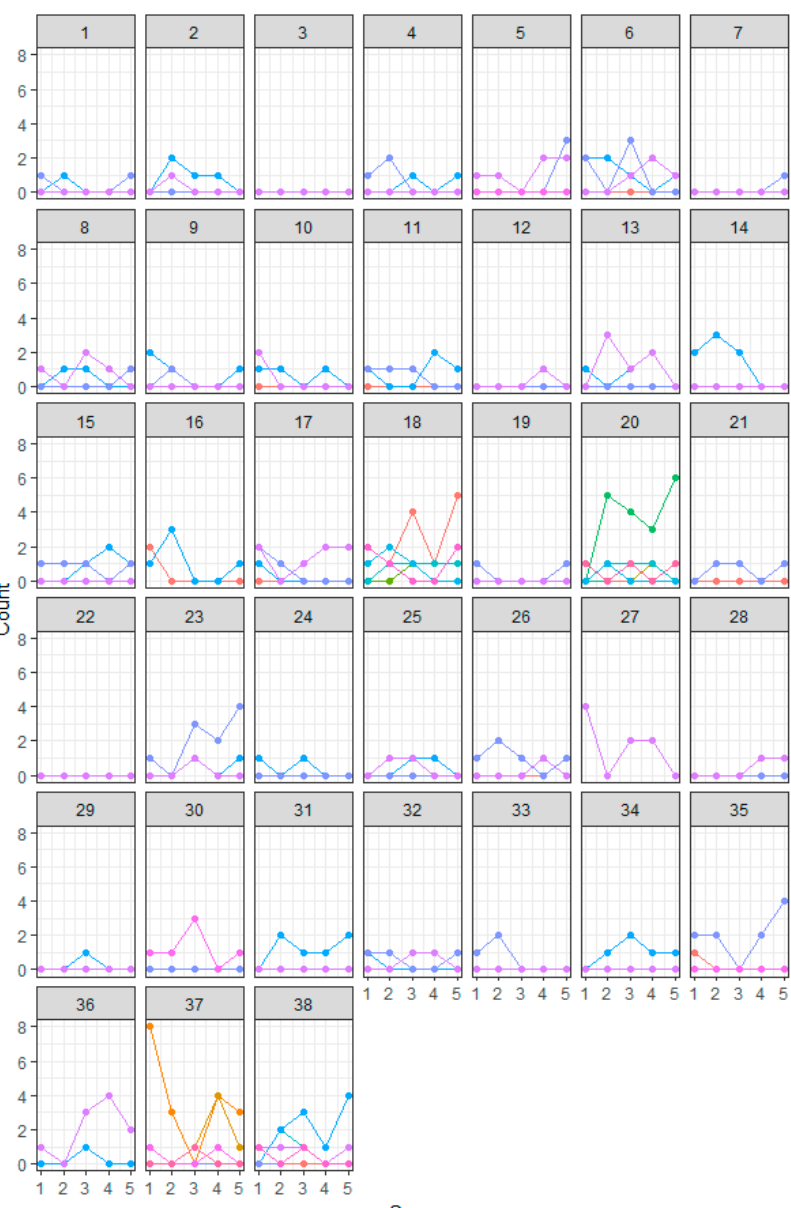
Figure A1. Visualization of the within-visit variation in counts at sites with at least one observed 0 which we use to demonstrated that variation in the number of heads counted can be related to turnover of specific individuals at the surface. Each panel represents a site, each line within a panel represents a visit, and the points joined by the lines show the number of heads observed in each of the five scans (blue to red color shades correspond to scan one through five). Here we show only visits that had at least a single count of zero to emphasize the fact that there is a high rate of turnover within visits (demonstrated by the variation between scans). We note that these observations are subject to imperfect detection, but conditions for each visit were similar, and in the absence of available empirical data on emergence rates, this serves as good evidence that we are not simply counting exactly the same individuals in each scan, i.e., there is randomness associated with which individuals are available to be detected from scan-to-scan. Raw data for all data are provided here archived address here